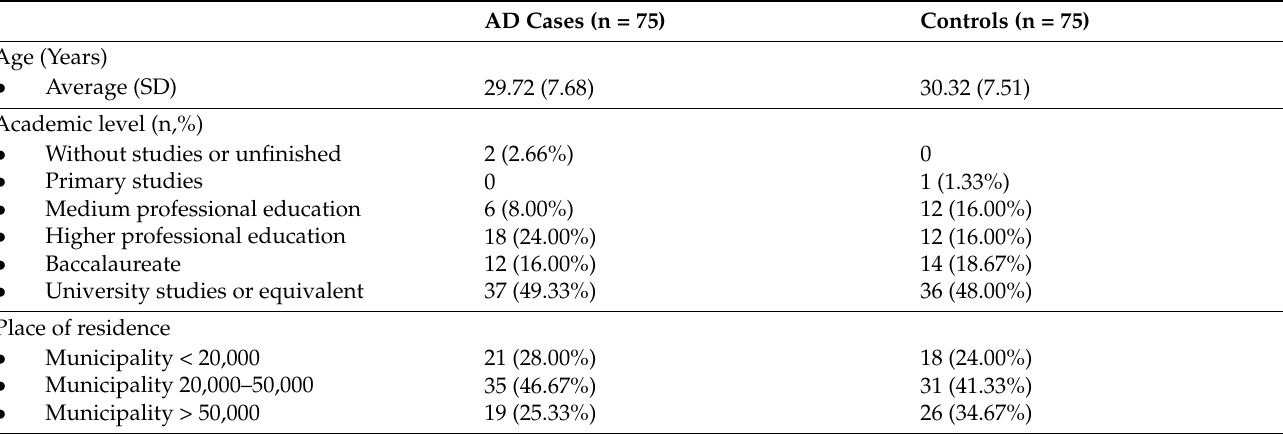
Table 1. Sociodemographic characteristics of our